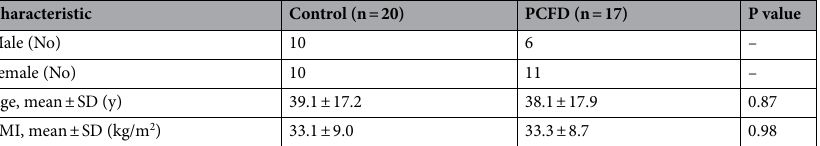
Table 1. Progressive collapsing foot deformity and control patients’ demographics. BMI body mass index; PCFD progressive collapsing foot deformity; – no statistical comparison; SD, Standard deviation; kg, kilograms; m, meters; y,